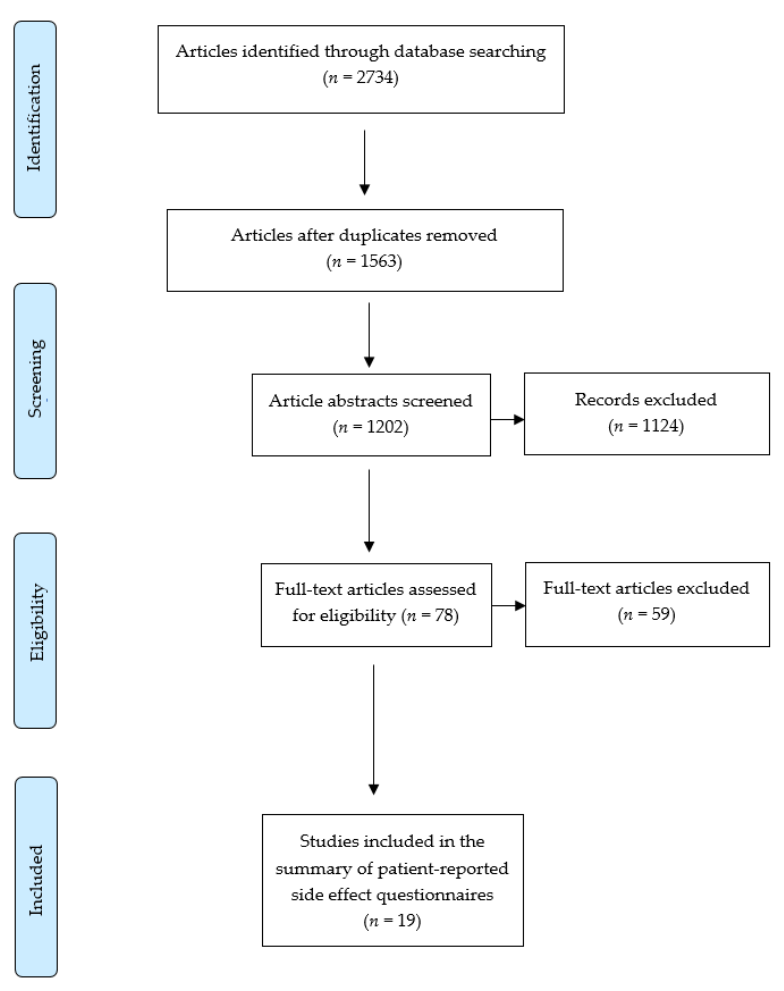
Figure 1. PRISMA flowchart for study selection. Table 1. List of questionnaires included in this systematic